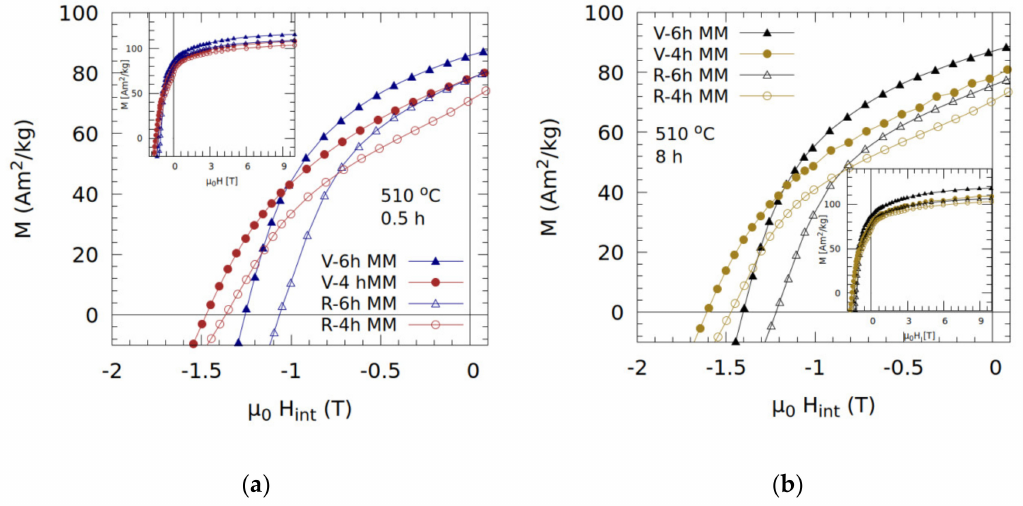
Figure 6. The demagnetization curves for virgin (V) and recycled (R) samples milled for 4 or 6 h and annealed at 510 ◦ C ( a ) for 0.5 h and ( b ) 8 h. Magnetization curves, up to 10 T, for the respective samples are given in the figure